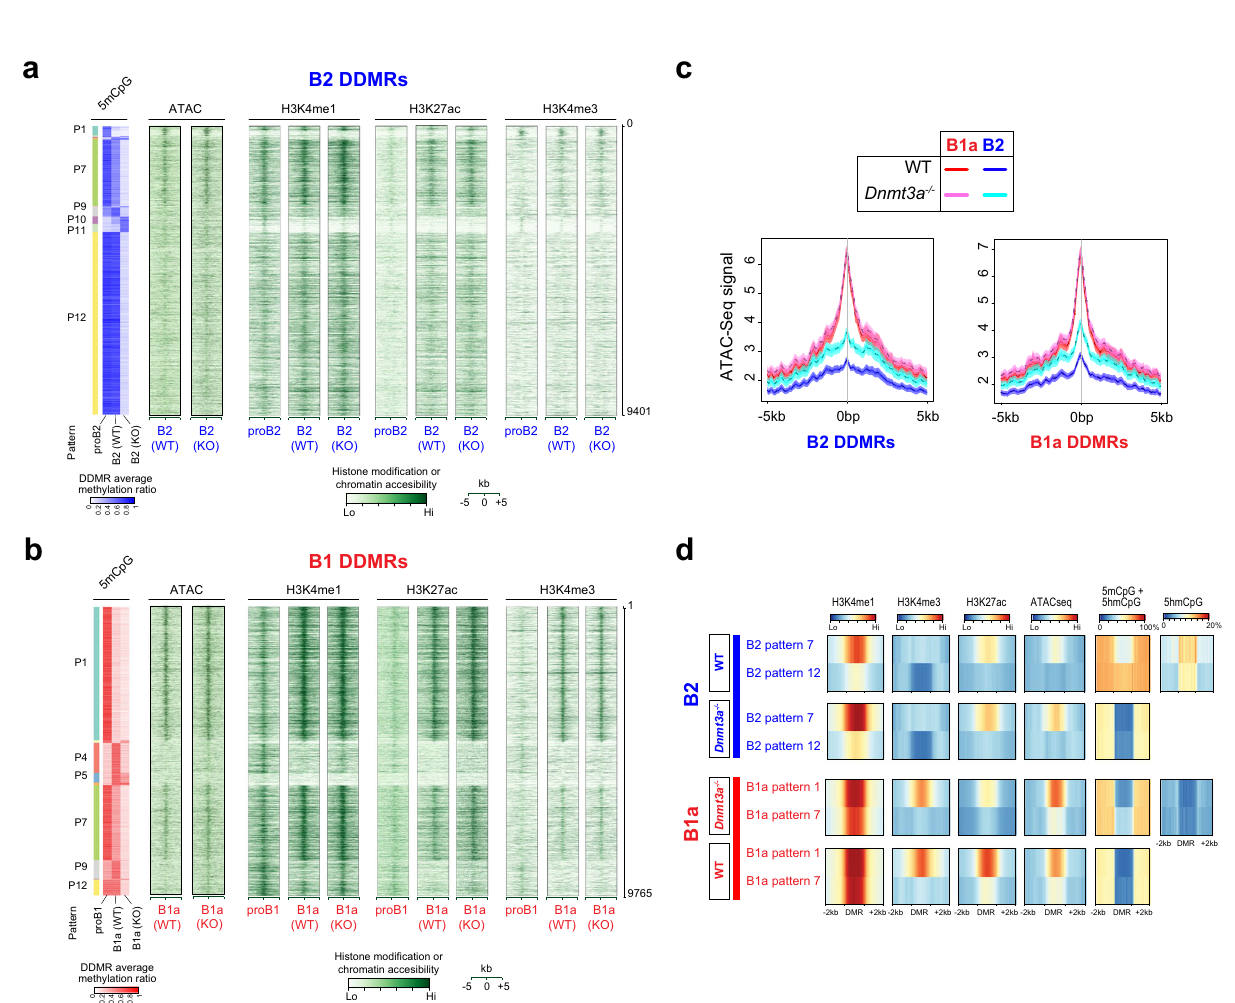
Fig. 6 DDMRs exhibit enhancer marks that are modulated by CpG modi fi cation patterns. a and b 5mCpG, H3K4me1, H3K27Ac, H3K4me3 and ATAC- Seq signal in B2 and B1a DDMRs in proB, WT B and Dnmt3a -/- B cells in the B1a and B2 lineages, respectively. An aggregate signal derived from 3 to 4 ATAC-Seq or CUT&RUN replicates per condition is plotted. The average CpG methylation ratio within the B1a and B2 DMRs is reproduced from Fig. 5E to provide a frame of reference alongside a heatmap of histone modi fi cations, as measured by CUT&RUN or chromatin accessibility signals in 100 bp bins in ±5 kb regions from the center of the DMRs. The six main patterns of methylation are labeled. c Pro fi les of chromatin accessibility in B1a and B2 DDMRs as measured by ATAC-seq. d The average pro fi le of modi fi ed CpGs, H3K4me1, H3K4me3, H3K27ac, and chromatin accessibility in the two largest patterns of B1a and B2 DDMRs in WT and Dnmt3a -de fi cient B1a and B2 cells, respectively.